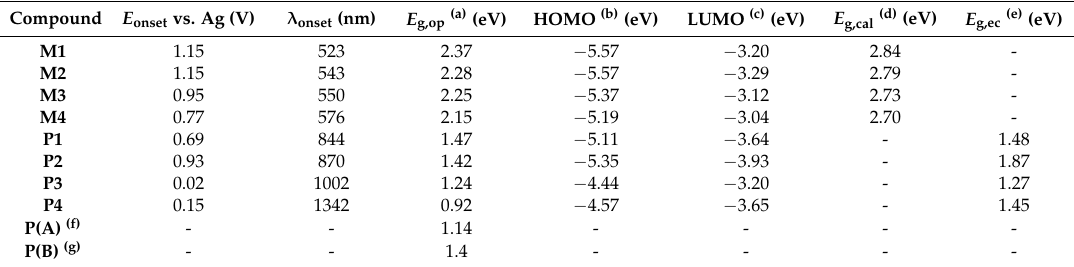
Table 2. The onset oxidation potential ( E onset ), absorption onsets wavelength ( λ onset ), optical band gap ( E g ), HOMO and LUMO energy levels and electrochemical band gaps of the monomers and the corresponding